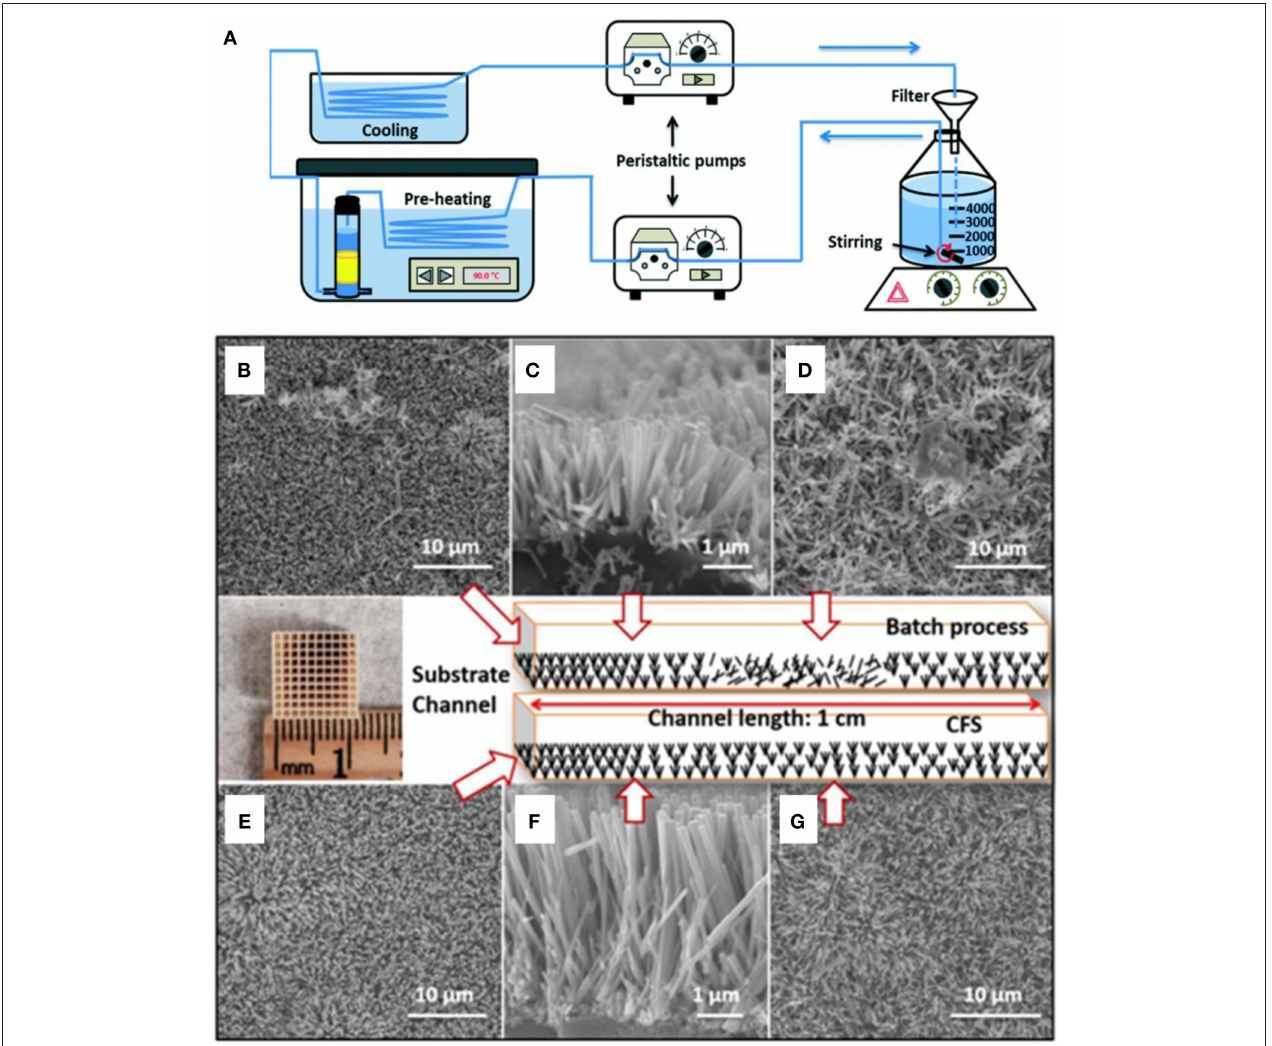
FIGURE 2 | (A) Experimental setup of the continuous flow growing method. SEM images of typical ZnO nanoarray obtained from batch process: (B) top view and (C) cross-sectional view of channel end, and (D) top view of middle area; ZnO nanoarray achieved by CFS: (E) top view and (F) cross-sectional view of channel end, and (G) top view of middle area. Reprinted with permission from Wang et al. (2017). copyright 2017 The Royal Society of